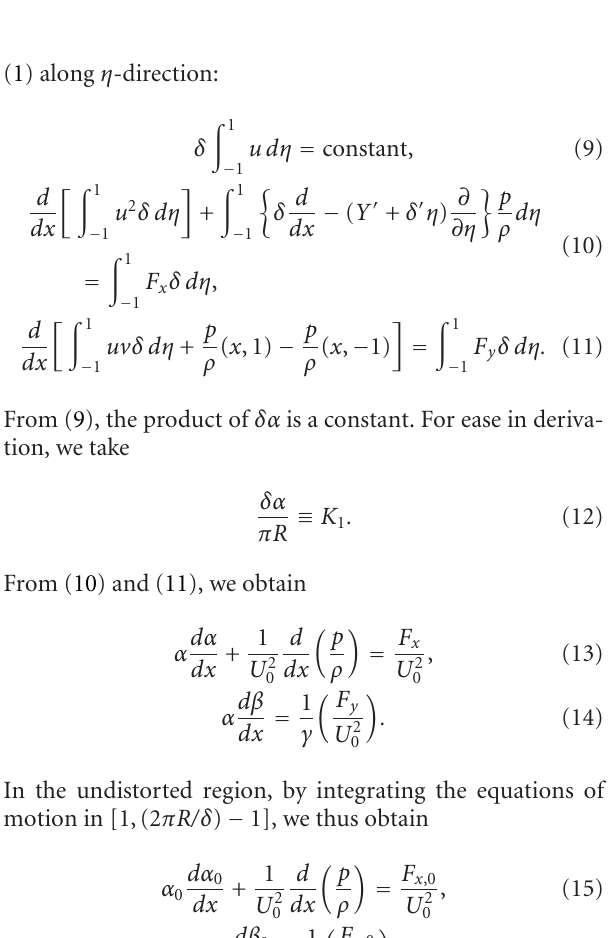
Figure 3: The force diagram and velocities in the compressor